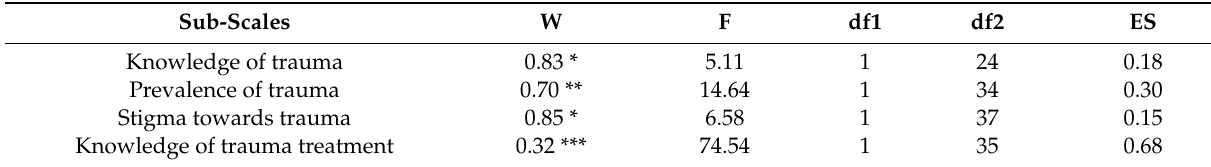
Table 3. One-way repeated measures analysis of variance (ANOVA) examining change in trauma subscale scores from pre- to post-workshop.